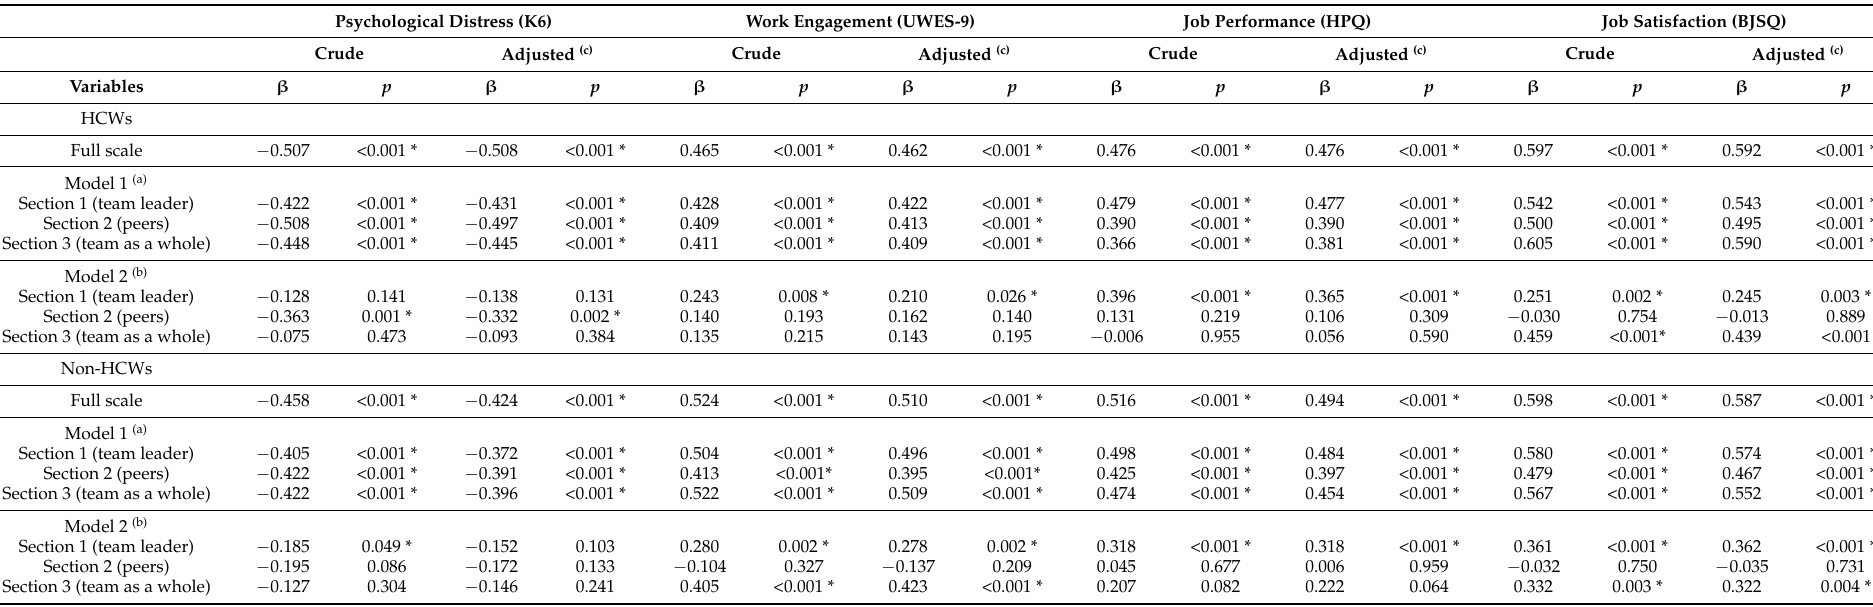
Table 6. Associations of psychological safety scale with psychological distress, work engagement, job performance, and job satisfaction. Psychological Distress (K6) Work Engagement (UWES-9) Job Performance (HPQ) Job Satisfaction (BJSQ) Crude Adjusted (c) Crude Adjusted (c) Crude Adjusted (c) Crude Adjusted